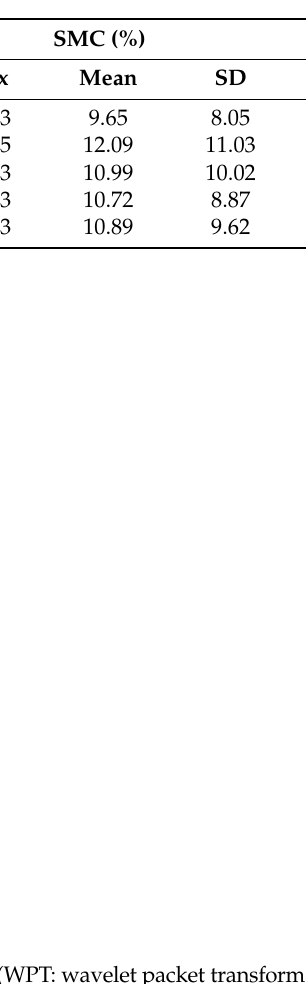
Table 2. Descriptive statistics of SMC in soils.